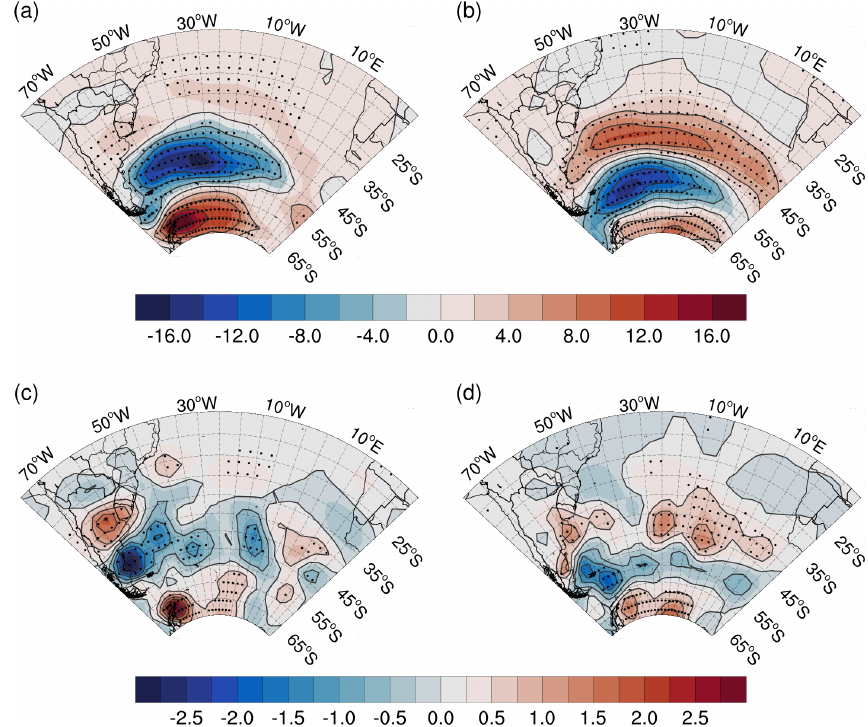
Figure 6. Cyclone (a, b) track and (c, d) genesis density differences between phases A and B of (a, c) EOF1 and (b, d) EOF2 of u 10 . Differences are calculated using phases A minus B and are also contoured by 5 density unit intervals for the track and 0.5 for the genesis. The black dots indicate where the difference is significant within a 95% confidence level. Density unit is the system per year per area, where area is in 10 6 km 2 ( ∼ 5 ◦ spherical